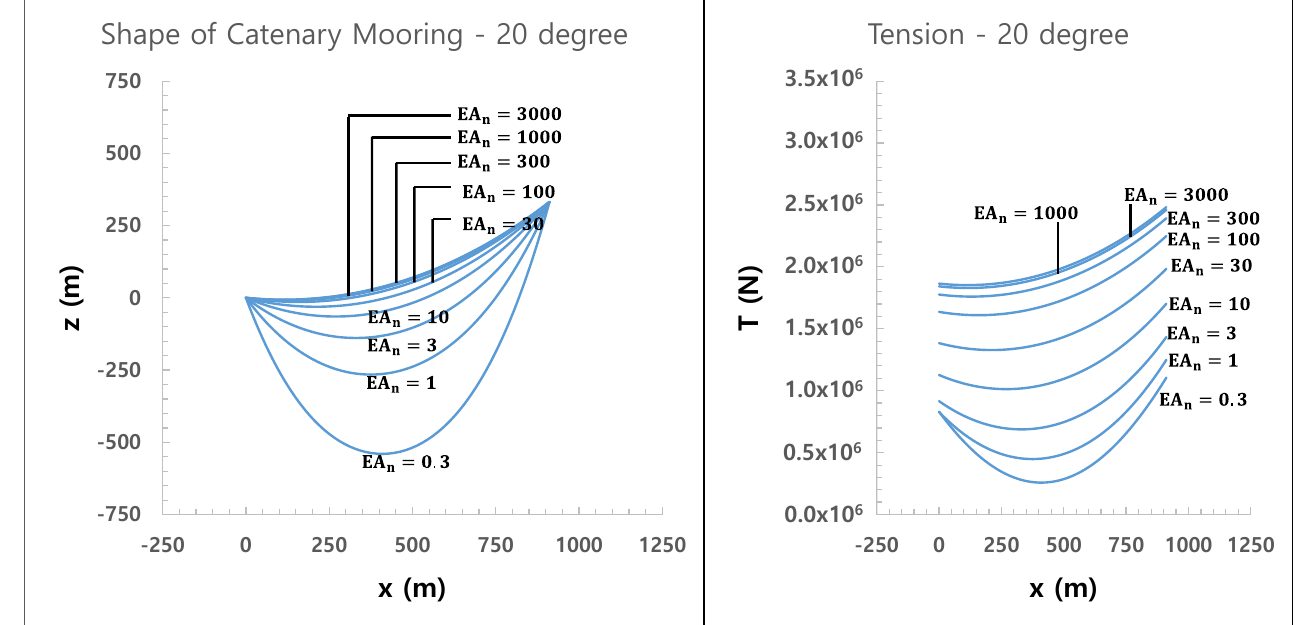
Figure 5. Results for static analysis of mooring line when q is 0°.